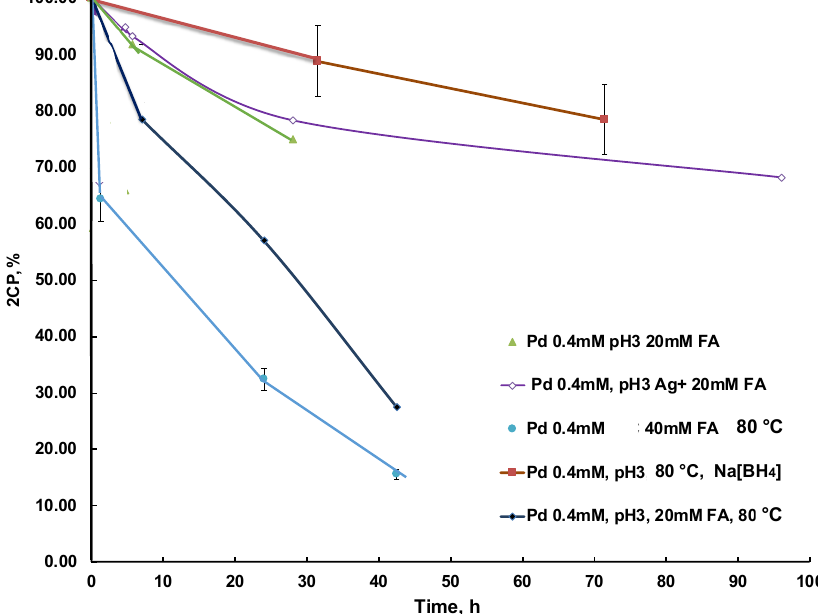
Figure 9. Kinetic curves of catalytic 2CP decomposition in the presence of CHI-GA-PdNPs 0.4 mM (21 µg PdNPs) cryogels in a batch mode at various parameters: added Ag, formic acid concentration, temperature and pH. The reaction mixture: 2CP (51.2 ppm), formic acid (20 mM), and pH 3. The concentration of contaminant was measured using